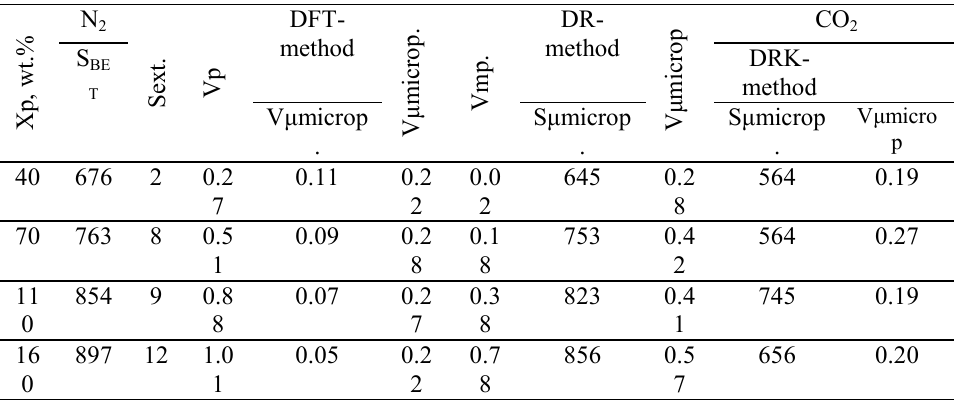
Table 1 . Textural parameters deduced from N 273 K on ACs prepared at different impregnation ratios (X